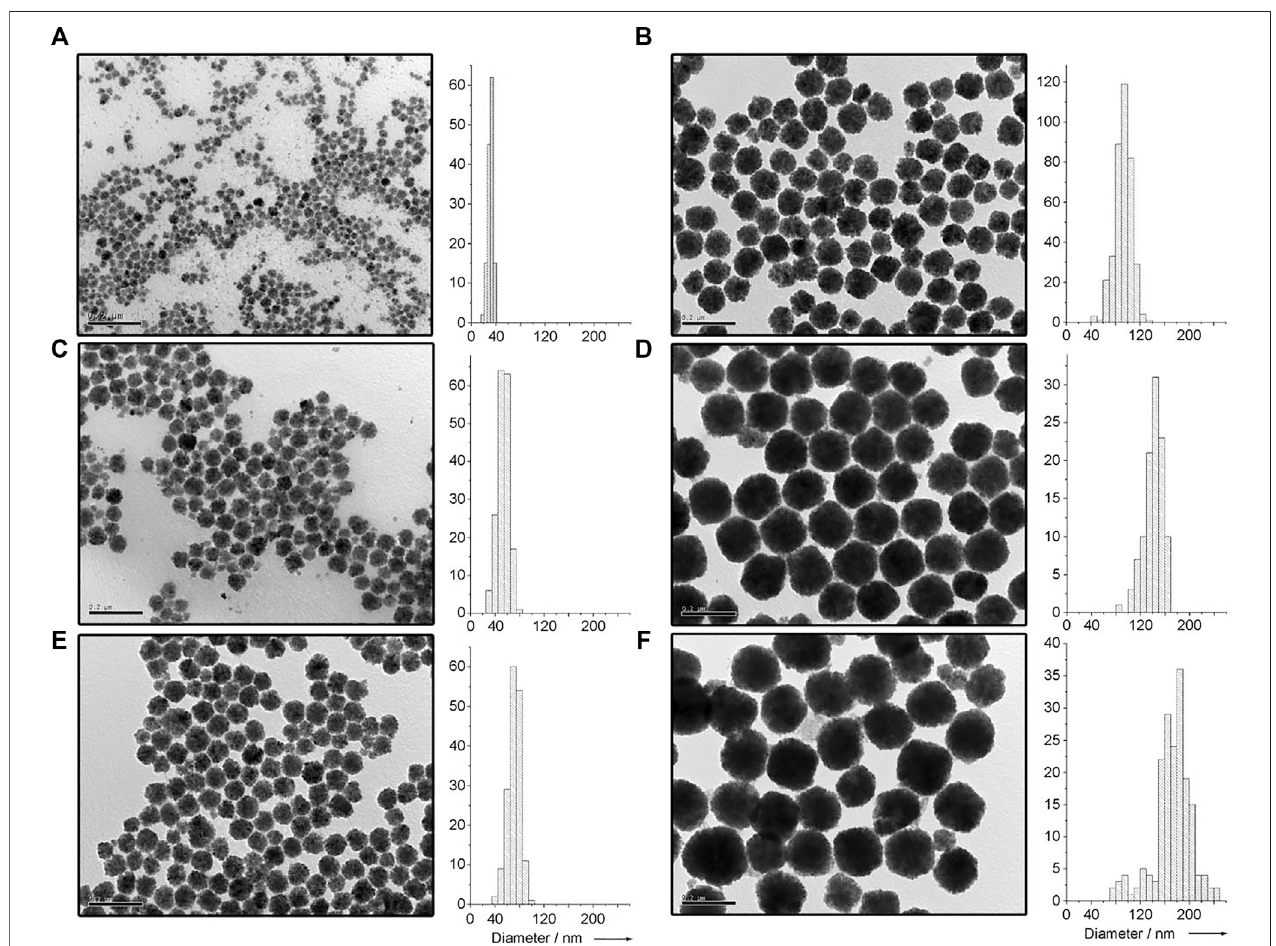
FIGURE4| TEMimagesofMNPs.TheaveragediametersoftheMNPscanbecontrolledfrom30to180 nm (A – F) byincreasingtheamountofNaOH(25 M)inthe system. Reprinted with permission from Ge et al. (2007). Copyright © 2007 John Wiley and Sons.